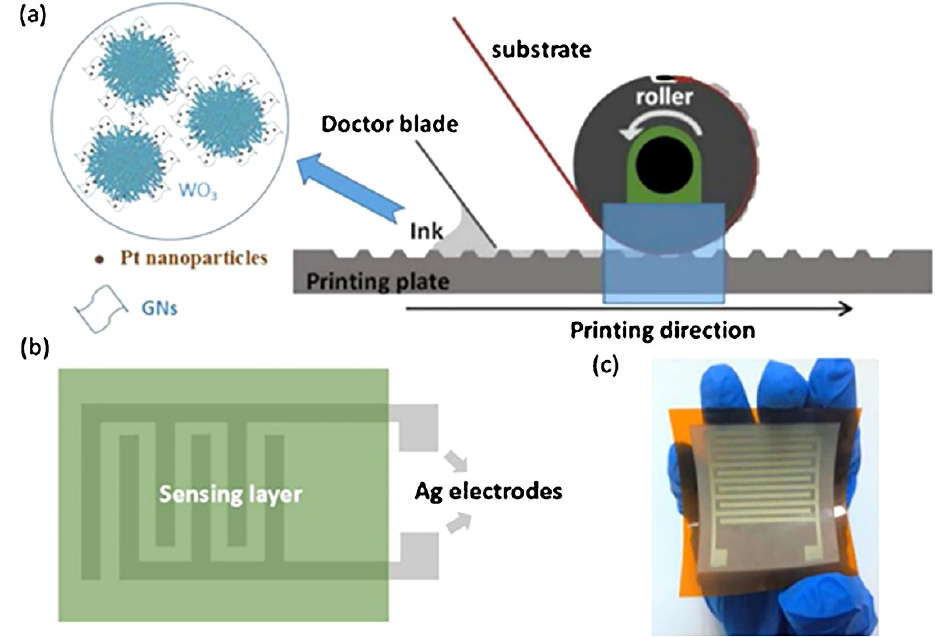
Figure 9. ( a ) Schematic representation of the gravure printing process; ( b ) Schematic of the printed sensor; ( c ) Photo of a printed WO 3 /Pt-GNs sensor on a PI substrate. Reproduced from ref. [145]. Copyright 2018, Elsevier, Ltd.